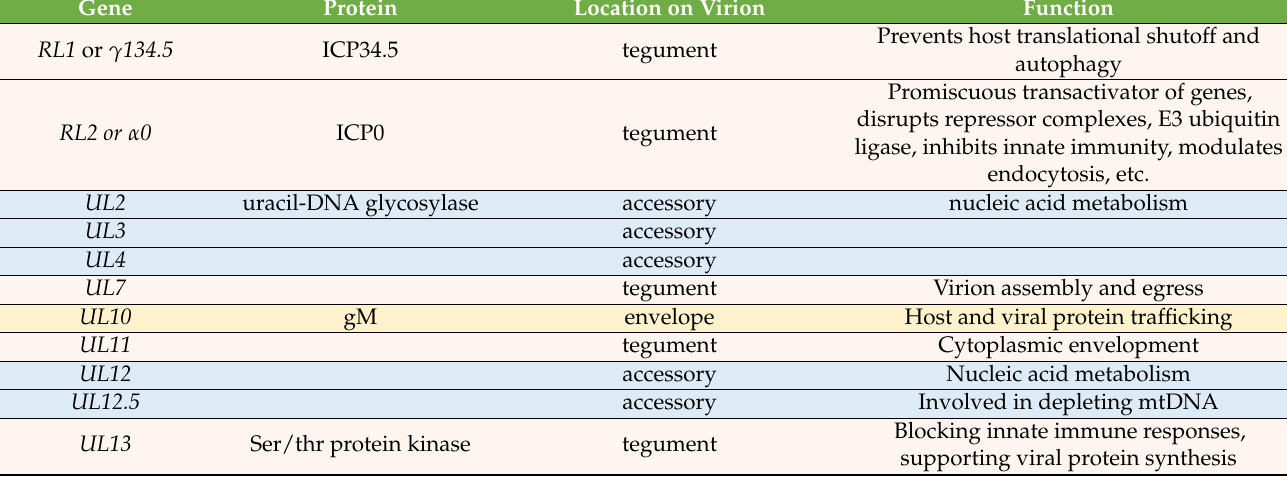
Table 1. Non-essential genes of HSV-1, corresponding proteins, their location on the HSV-1 virion, and their function. Pink: tegument proteins, blue: accessory proteins, yellow: envelope proteins, green: capsid proteins.